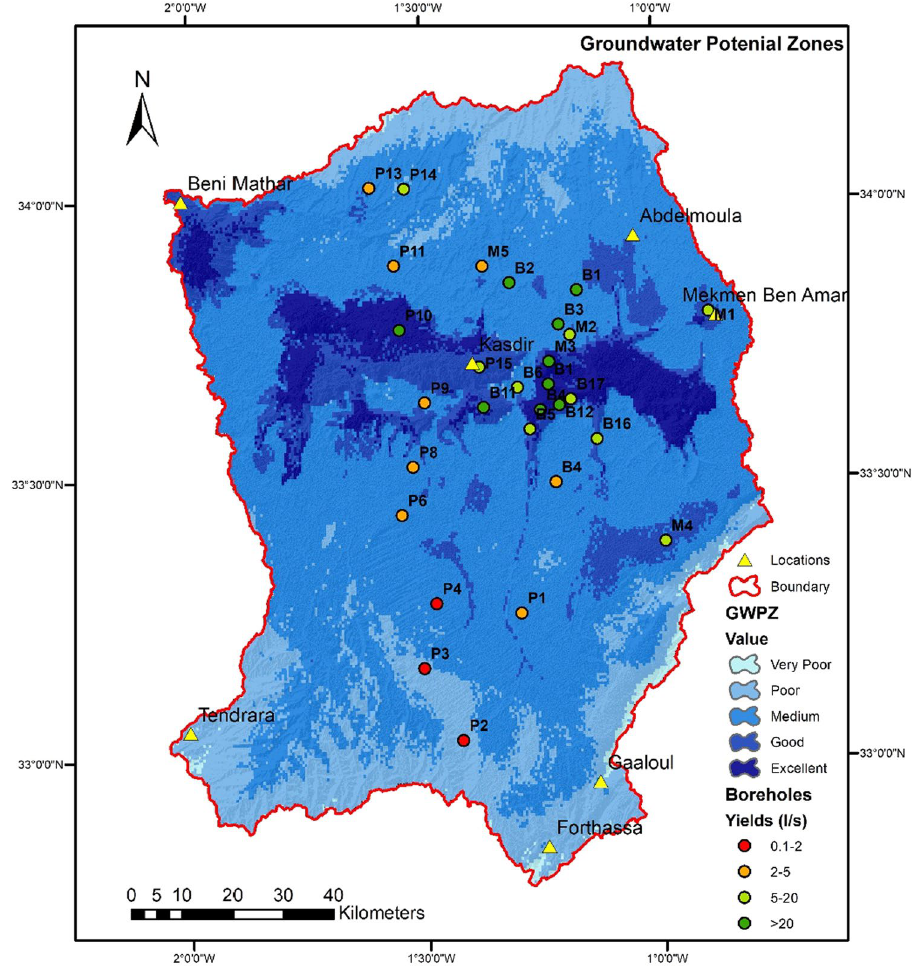
Fig. 4 Groundwater